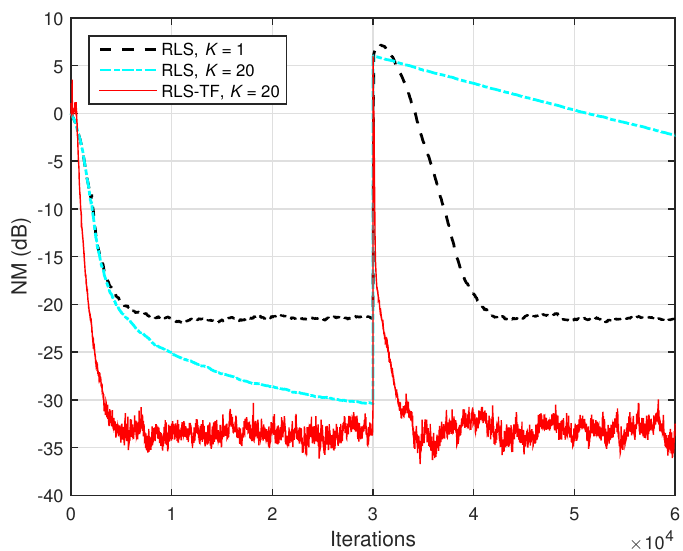
Figure 7. Normalized misalignment (NM) evaluated based on (58), in dB, for the identification of the global impulse response h (of length L = 2048) from Figure 2d, using the conventional RLS algorithm (with different values of the forgetting factor λ = 1 − 1/ ( KL ) , varying the value of K ) and the RLS-TF algorithm (with the forgetting factors λ i = 1 − 1/ ( KL i ) , i = 1,2,3, where K =